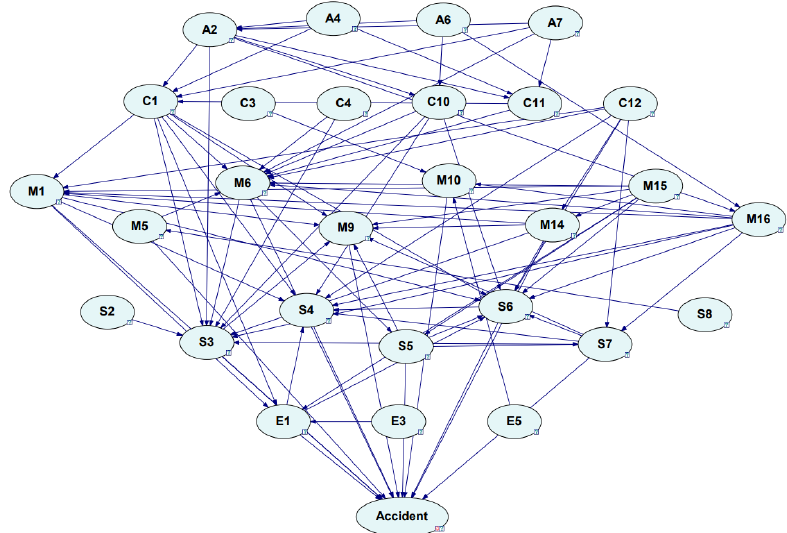
Figure 11. Bayesian network topology of safety risk factors.